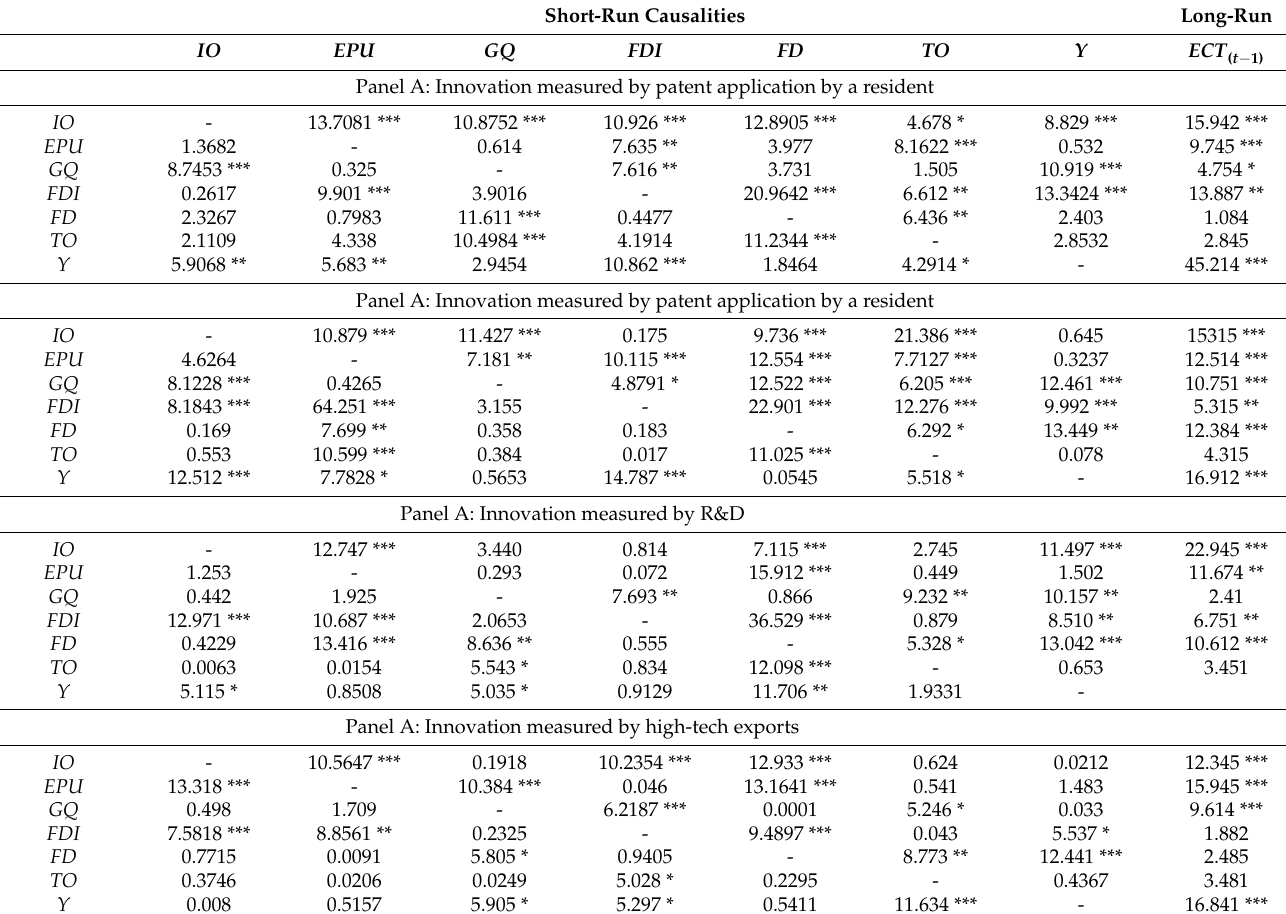
Table 13. Result of system GMM specification causality test.